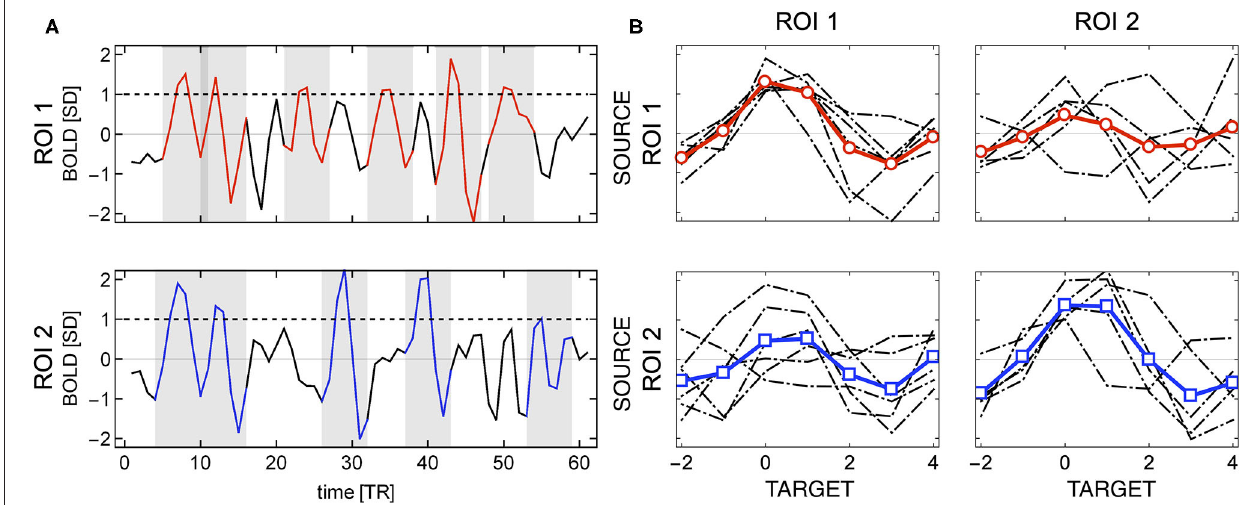
FIGURE 2 | Example of directionality in source events of two regions of interest. (A) The shaded areas indicate the location of the source events (BOLD activity around threshold crossing). The source events of ROI 2 may appear at different times than source events of ROI 1 (e.g., around TR = 30 and TR = 40). (B) Individual events (in gray) and their averages (in red for ROI 1 and blue for ROI 2); source events are shown in the diagonal subplots, and target events in the off-diagonal ones. Different sets of source events for each ROI give rise to asymmetry in the correlations between any two regions.